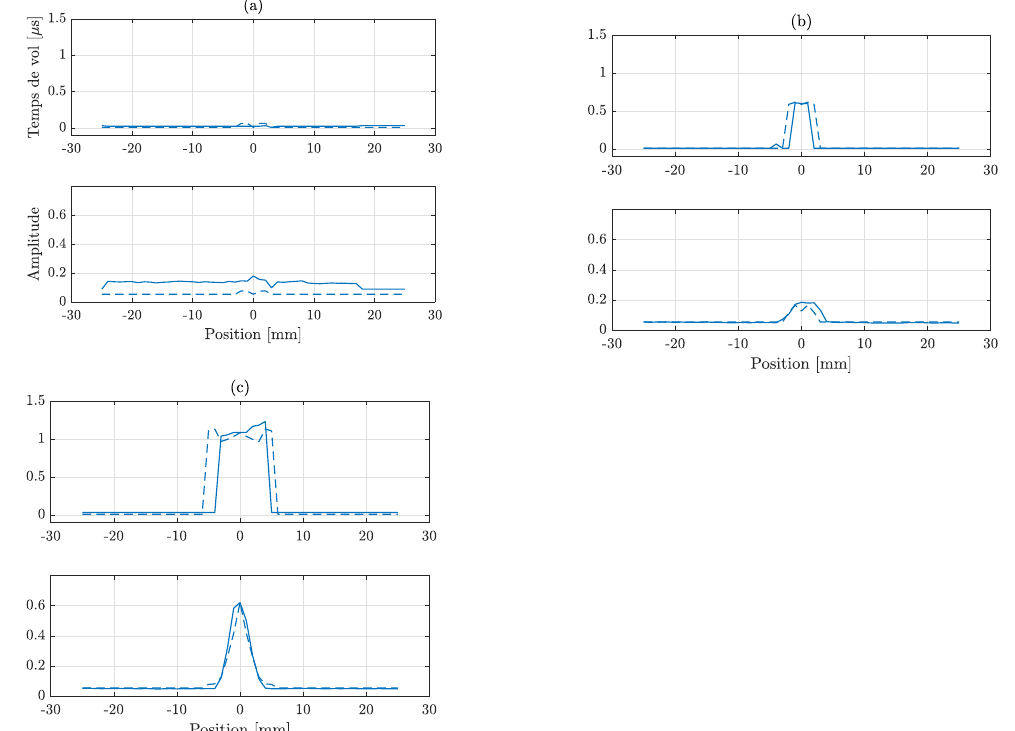
Figure 6. Time of Flight and echoes amplitudes obtained experimentally ( − ) and by numerical simulations ( −− ) for three SDHs of 2.5 mm radius and located at 1 ( a ), 3 ( b ) and 7.5 mm ( c )